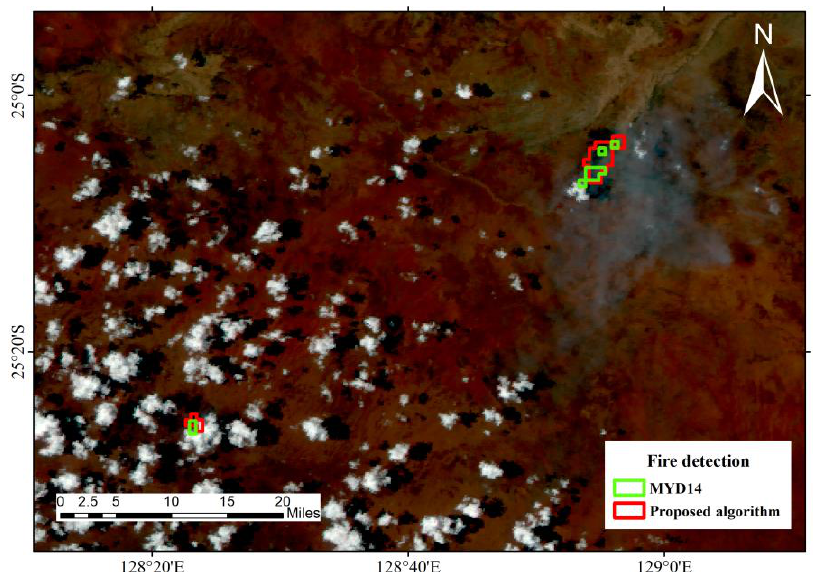
Figure 5. Comparison with MYD14 of 1 January 2020 fire results in Western, Australia.